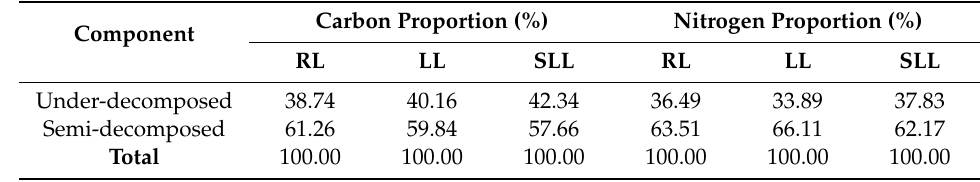
Table 7. Carbon and nitrogen distributions in the litter